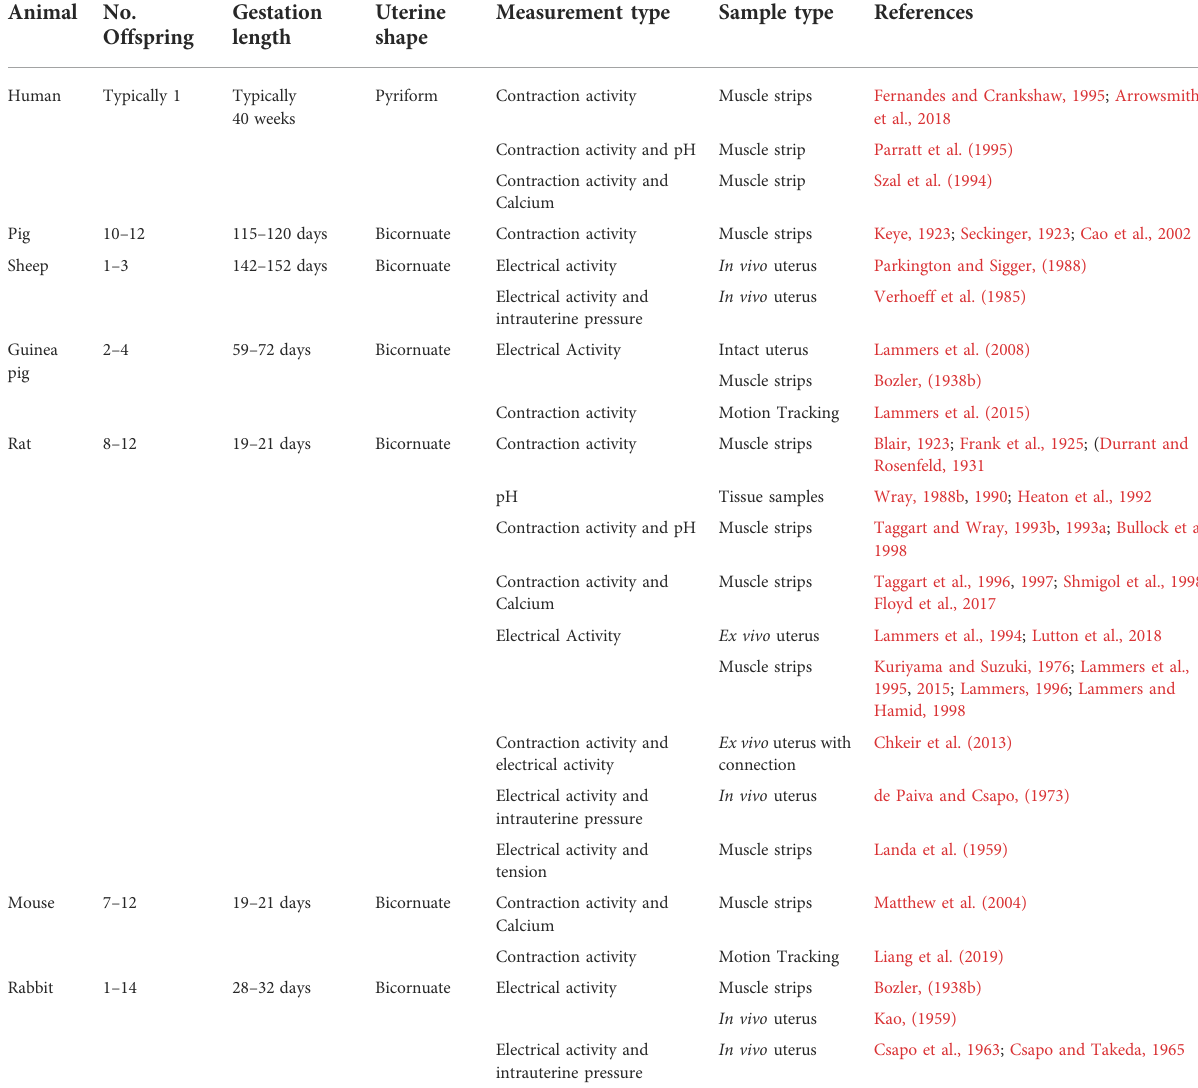
TABLE 1 Overview of species, physiology and experimental measures from the